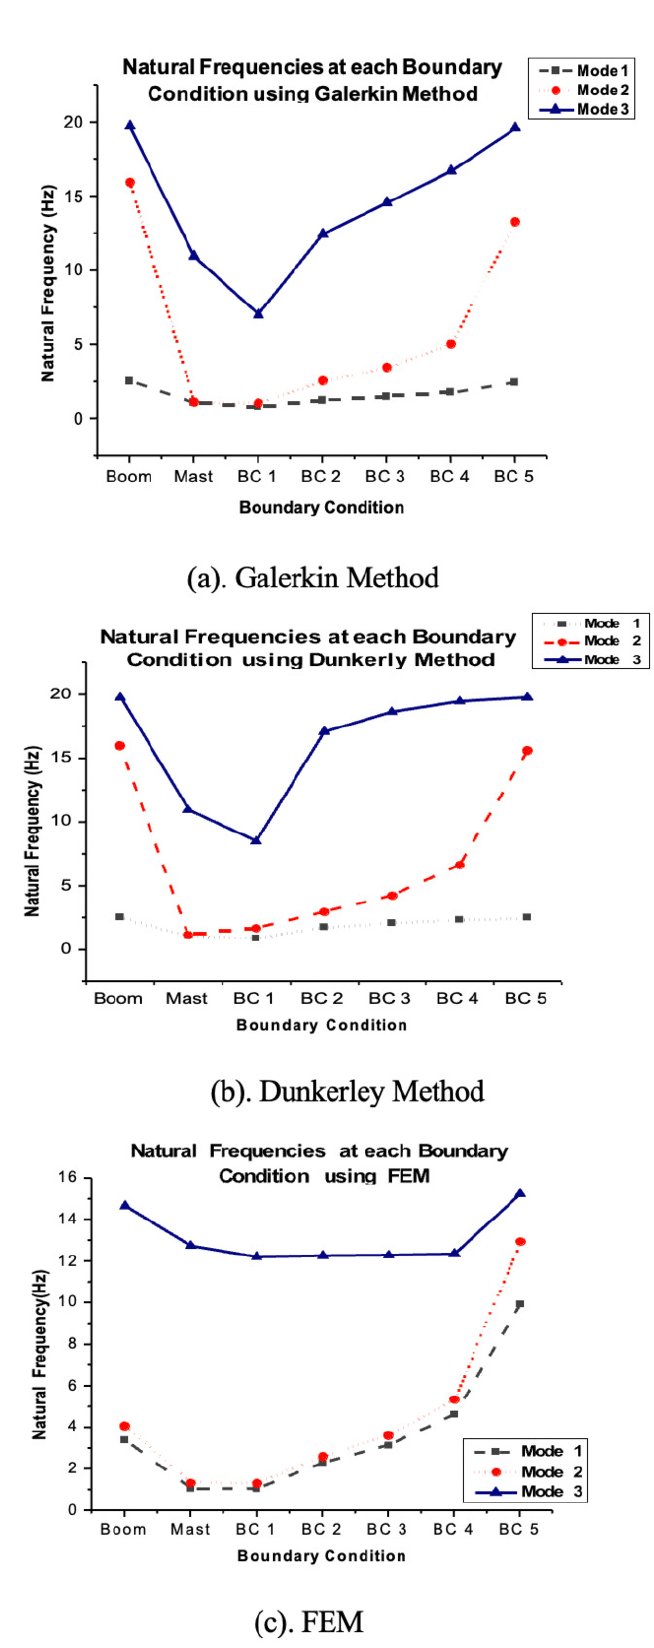
Figure 14. Natural frequencies of tower cranes with different boundary